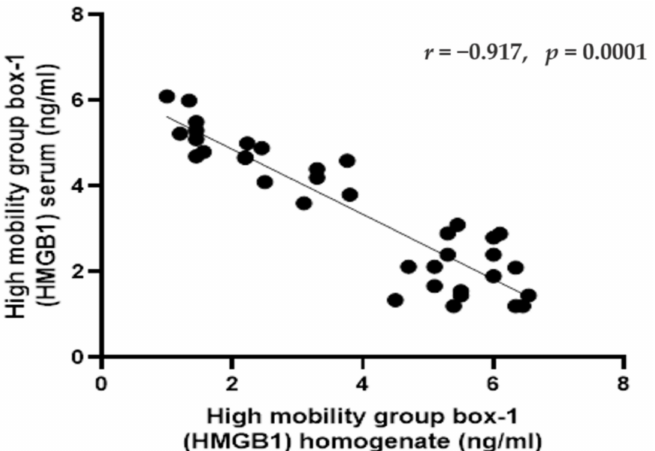
Figure 5. Pearson correlations between the high mobility group box-1 (HMGB1) (in the serum and homogenate) in rats in different groups. Data were expressed as correlation coefficient and significance. Correlation was made using Pearson